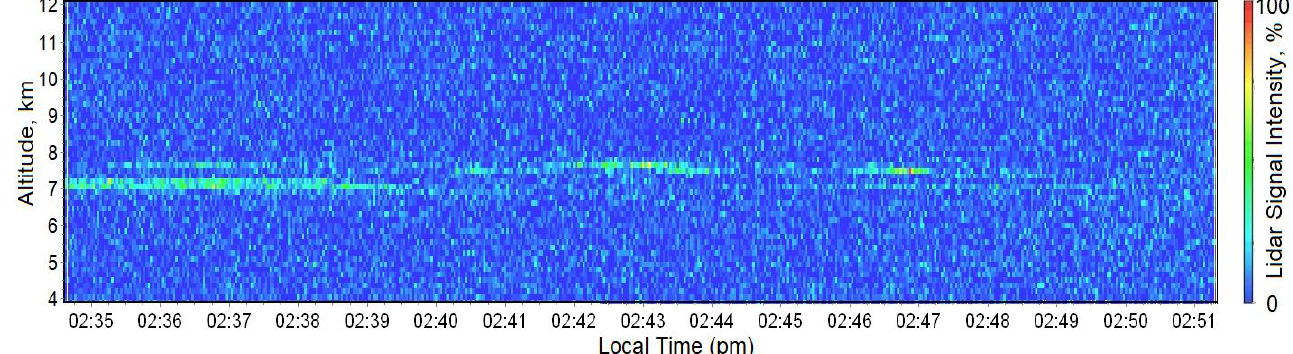
Figure 2. Temporal dynamics of the vertical profile of the lidar signal intensity (6 January 2021; series of measurements was performed from 2:34 to 2:51 p.m.).